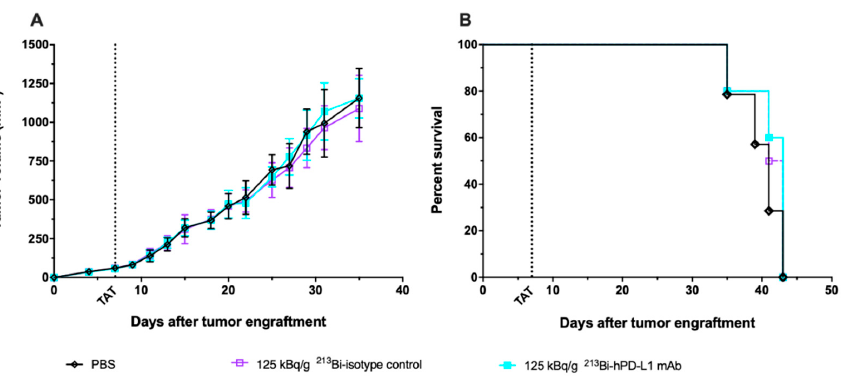
Figure 6. TAT using 213 Bi-anti-hPD-L1 mAb in PD-L1 negative M113 WT melanoma xenograft model. At day 0, NSG mice were grafted subcutaneously with 1×10 6 M113 WT melanoma cells that did not express PD-L1. At day 7, TAT was performed by i.v. administration of 125 kBq/g 213 Bi- Anti-hPD-L1 mAb ( , n = 10), 125 kBq/g 213 Bi IgG2b isotype control ( , n = 10), or PBS for control animals ( , n = 14). ( A ) Tumor volume, represented by mean and SD, was determined sequen- tially from engraftment until signs of tumor necrosis or volume reached 2000 mm 3 and animals were sacrificed. No difference was observed in tumor growth between the different groups. ( B )